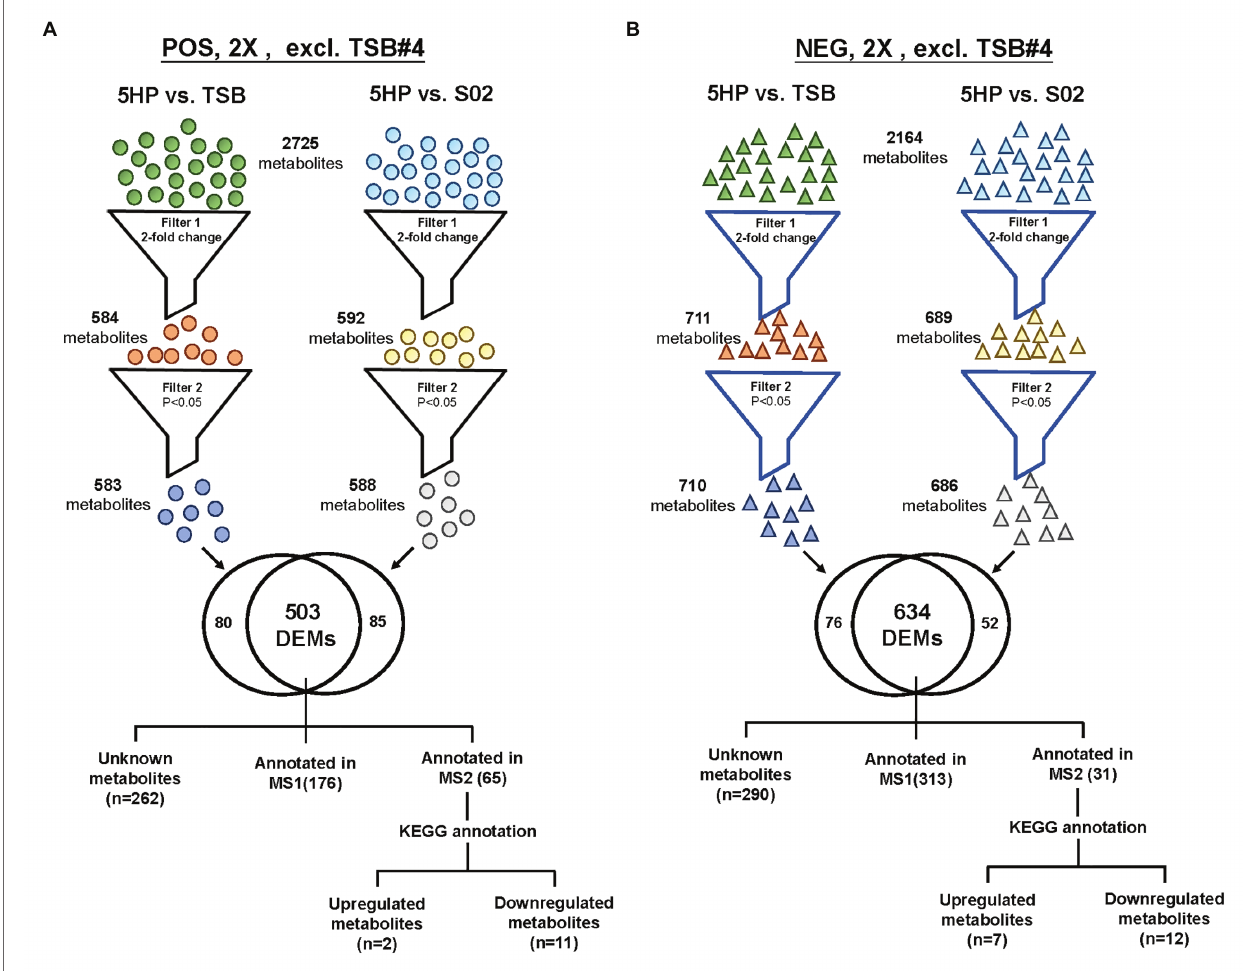
FIGURE 2 | The strategy of data filtering for shrimp metabolites. Comparison of DEMs in both POS ion and NEG ion modes of 5HP vs. TSB and 5HP vs. S02 at 12 hours post infection (hpi). (A) In POS ion mode, from the 2,725 metabolites, there was at least one 5HP, TSB, or S02, 503 DEMs with a 2-fold change ( p < 0.05). (B) Similarly, from the 2,164 metabolites in NEG ion mode, 634 DEMs with a 2-fold change and p < 0.05 were obtained. The DEMs were further annotated using proprietary MS1, MS2 database, and Kyoto encyclopedia of genes and genomes